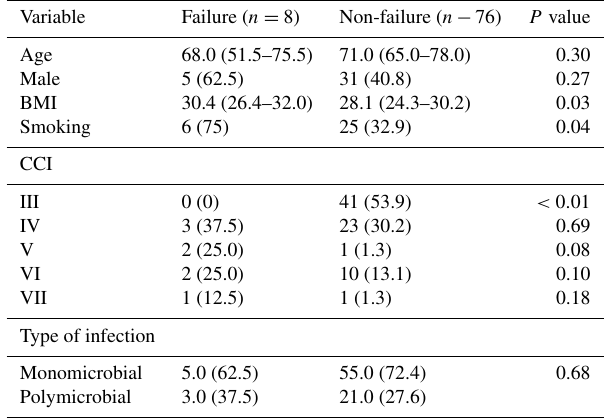
Table 5. Comparison of patients with and without failure.